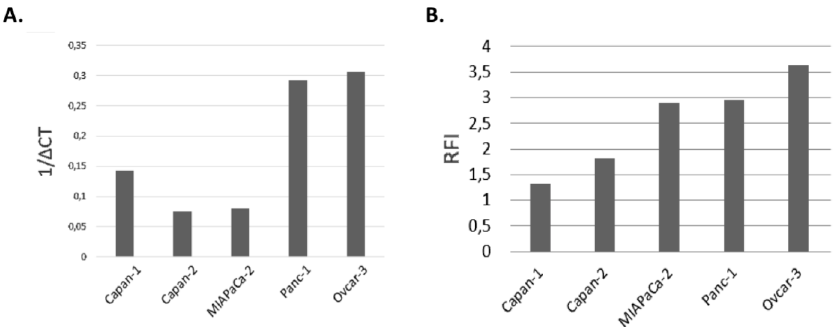
Figure 1. Transcriptomic and protein expression of folate receptor 1 (FOLR1) in pancreatic ductal adenocarcinoma (PDAC) cell lines and one ovarian cancer (positive control). ( A ) Expression of FOLR1 by RT-qPCR. ( B ) Membrane protein expression of FOLR1 by flow cytometry (RFI).